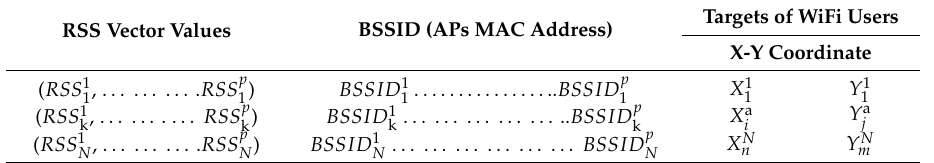
Table 1. Dataset